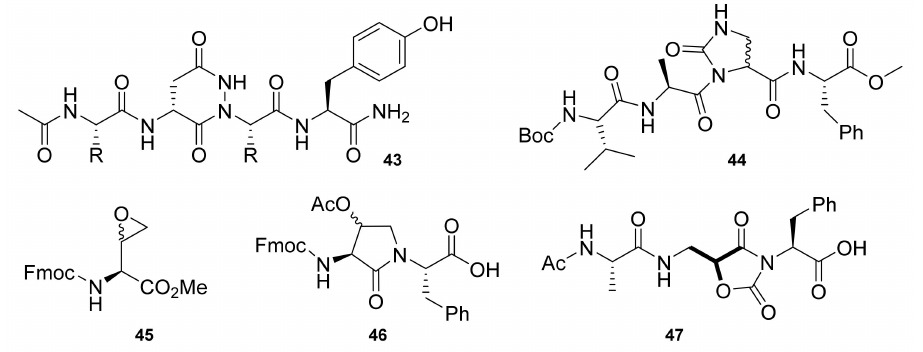
Figure 2. Mimetics based on peptide modifications.